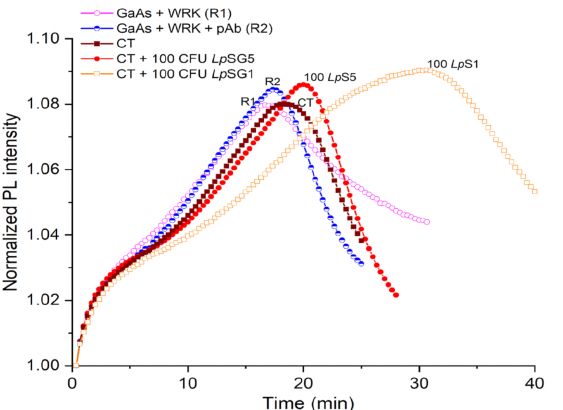
Figure 6. Normalized PL intensity of AMP-functionalized GaAs/AlGaAs DIP biochips (wafer D3422) exposed to CTW spiked with L. pneumophila at 100 CFU/mL. The purple open circle (R1) and blue semicircle (R2) plots represent reference without exposing to bacteria. The red full circle and brown square plots represent the biochip response to pAb-decorated L. pneumophila SG5 and SG1,